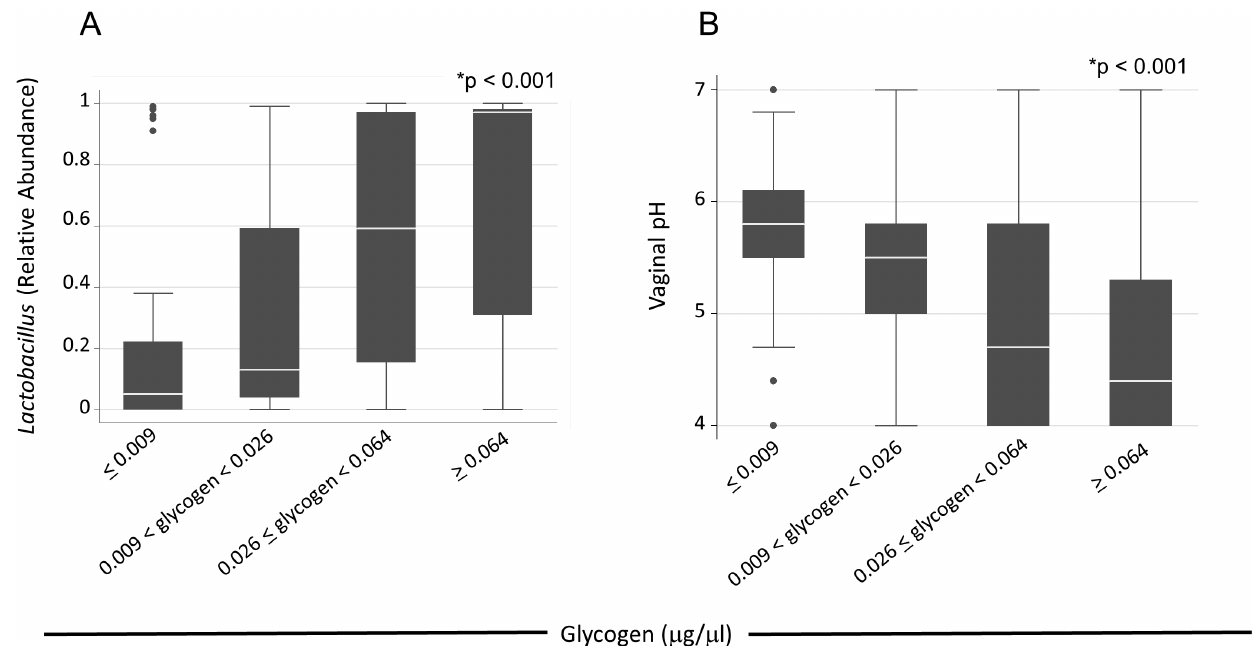
Figure 2. High levels of free glycogen are associated with a vaginal microbiota dominated by Lactobacillus species and a low vaginal pH. The final analytic sample consisted of 177 observations with non-missing values for both glycogen and Lactobacillus . Free glycogen was analyzed as a binary variable dichotomized about the median and categorically using cutpoints according quartiles of the distribution, as indicated. The distribution of Lactobacillus relative abundance (A) and vaginal pH (B) are summarized by glycogen as a continuous variable by glycogen quartiles. *p-value is estimated by extension of the Kruskal-Wallis test with adjustment for clustering among repeated measurements.